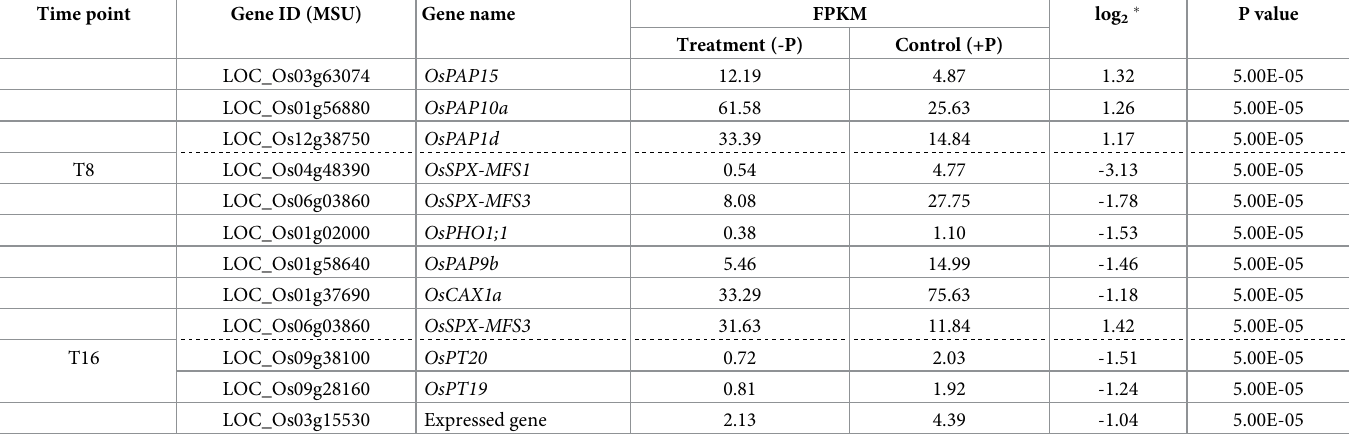
while five genes ( OsSPX-MFS1 , OsSPX-MFS3 , OsPHO1;1 , OsPAP9b and OsCAX1a ) were downregulated (Table 2). In T16, only one gene ( OsSPX-MFS3 ) was upregulated while three genes ( OsPT20 , OsPT19 and LOC_Os03g15530) were downregulated (Table 2). Most of the 32 Table 2. Differential gene expression among the 32 PRGs ‡ in rice flag leaves at 8 or 16 days after anthesis, following P withdrawal from the nutrient solution 8 d earlier. Time